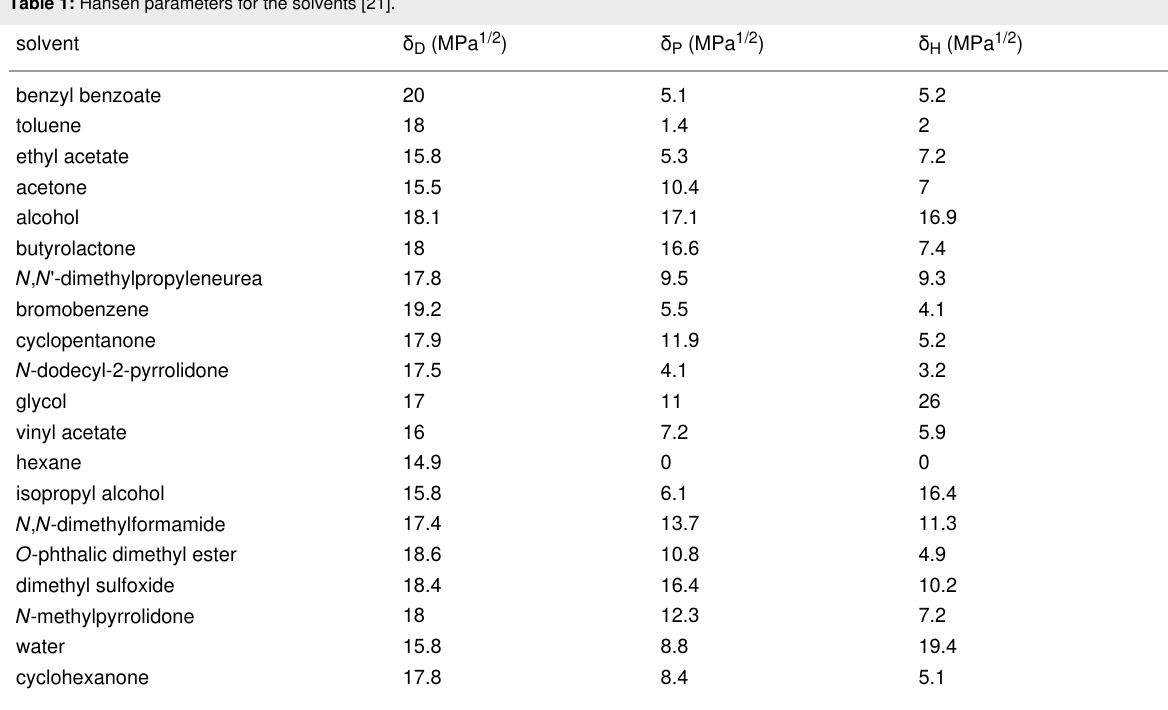
Table 1: Hansen parameters for the solvents